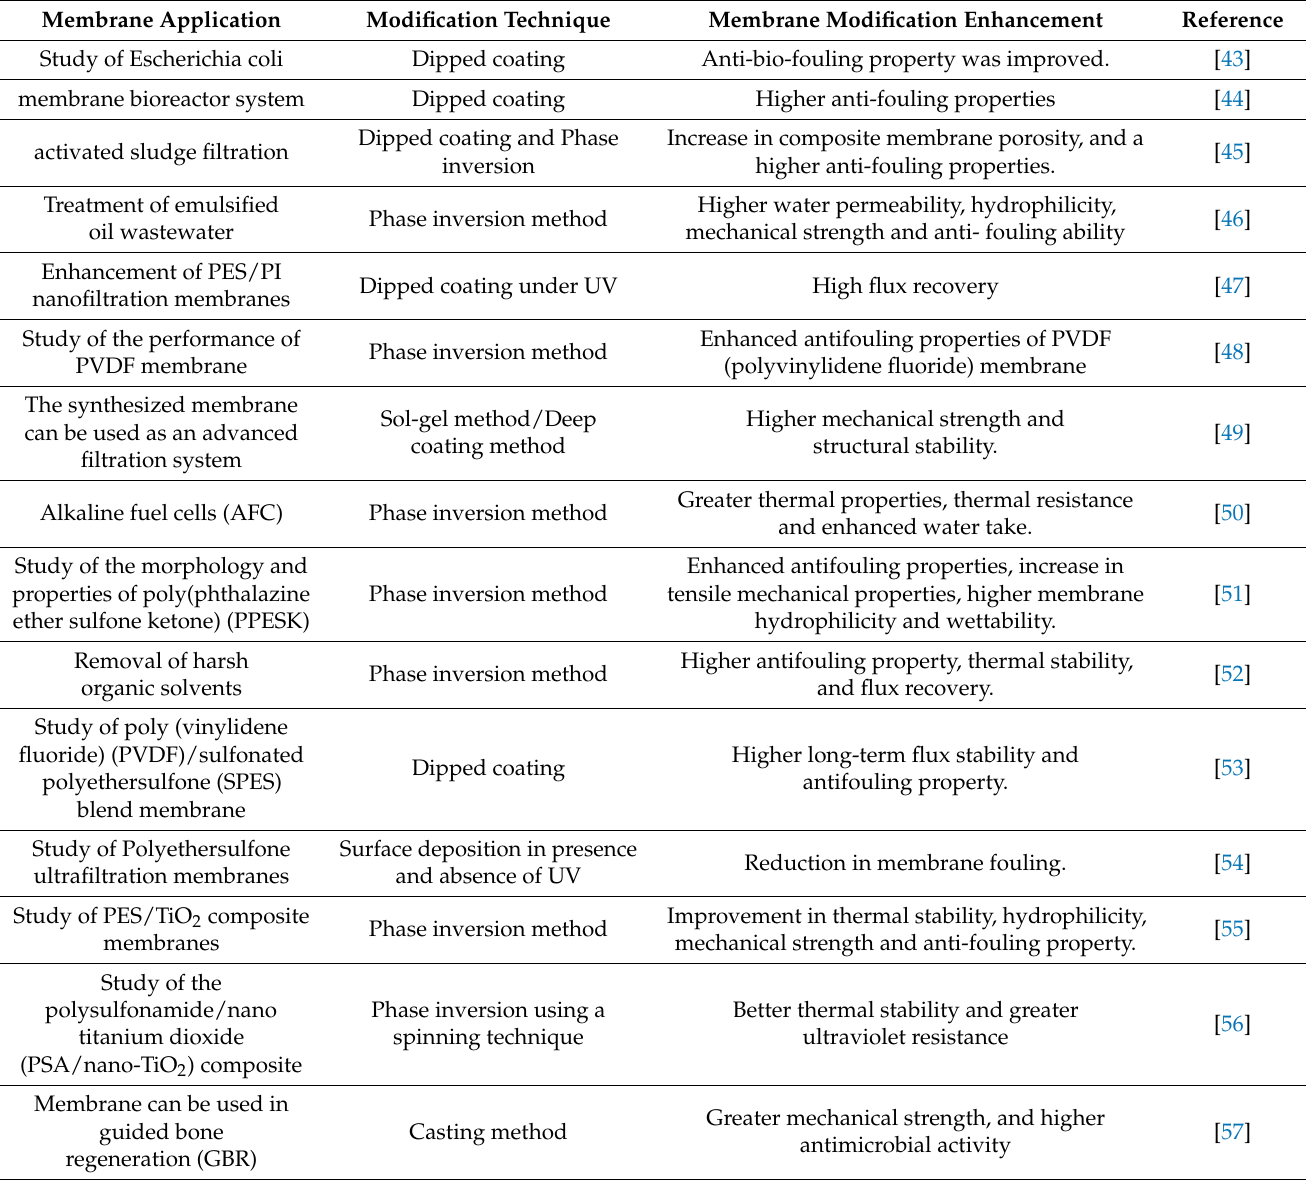
Table 2. A summary of key elements of TiO 2 nanoparticle-based nanocomposite membranes. Membrane